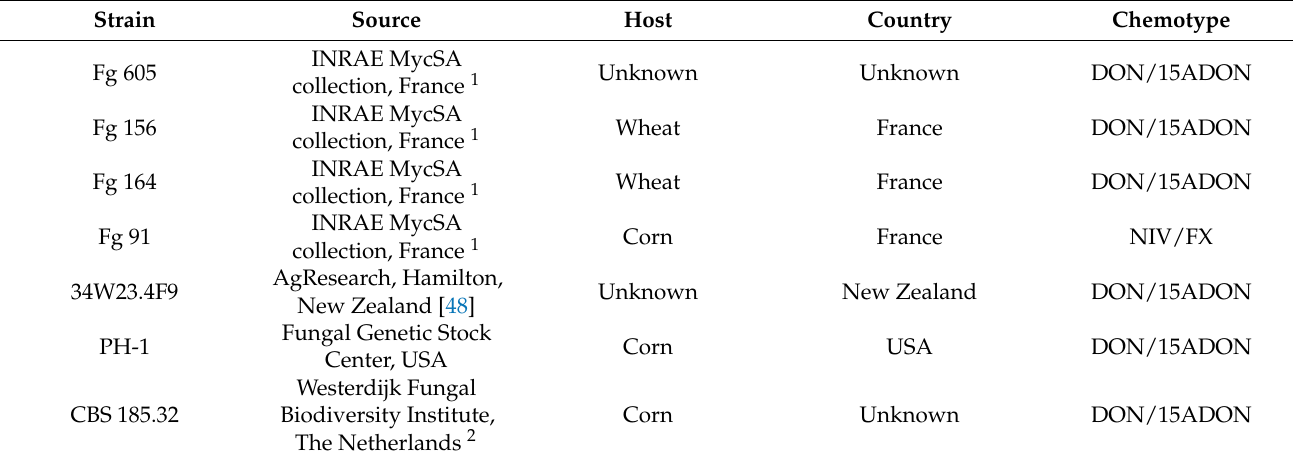
Table 3. Origin and characteristics of Fusarium graminearum strains used in this